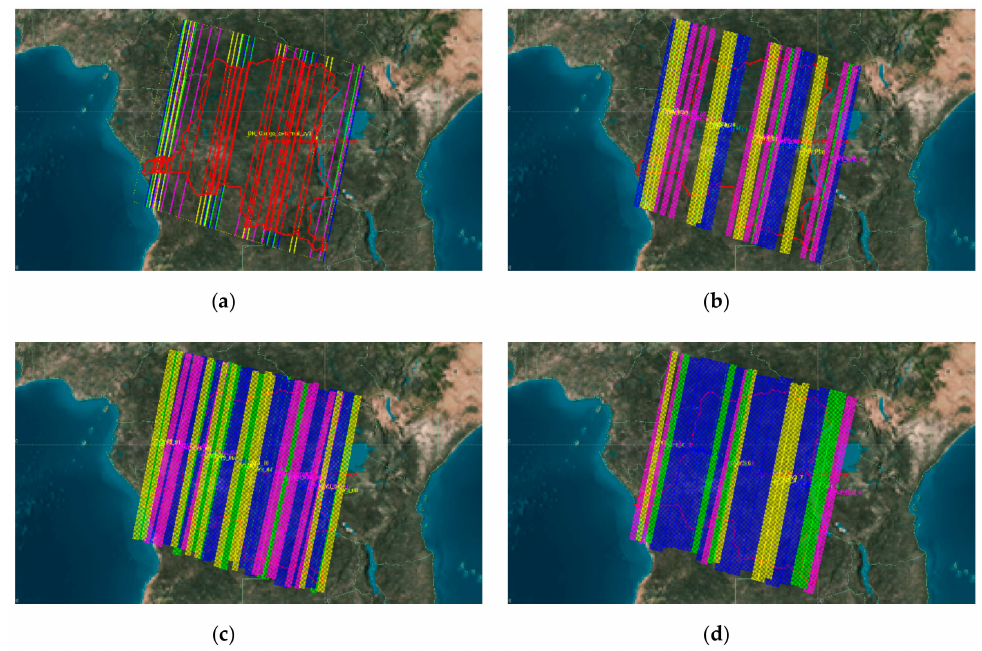
Figure 9. Mission planning results of di ff erent modeling methods in Congo: ( a – d ) Same as Figure 7. Table 4. Number of imaging strips and coverage rate obtained with di ff erent modeling methods. Target Region